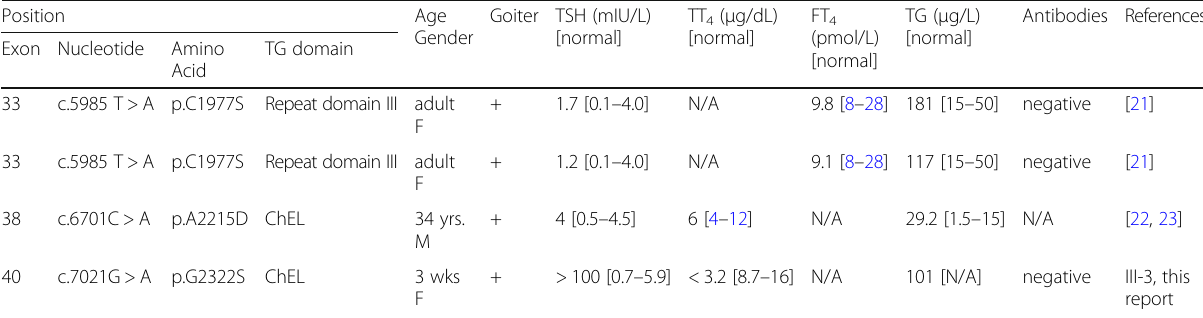
Table 1 Clinical characteristics of the CH cases due to the TG gene mutations with detectable TG levels